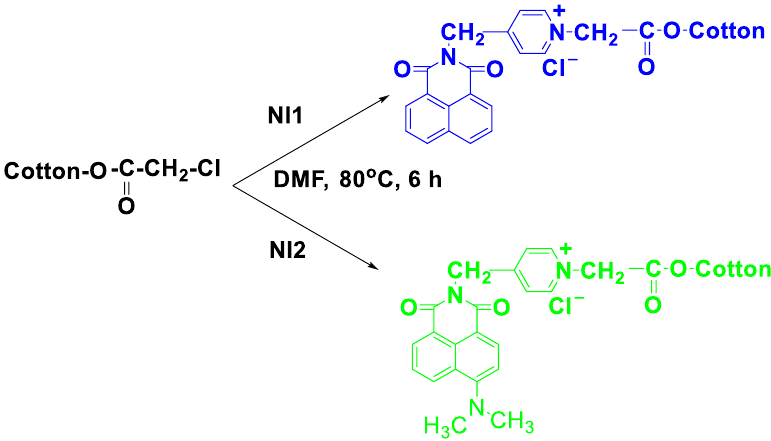
6 of 14 Figure 3. Absorption spectra of KI in the presence of NI2 plotted as a function of irradiation time ( A ); dependence of absorbance at 352 nm, corresponding to I 3- caused by NI1 and NI2 ( B ). 2.4. Dyeing of Modified Cotton Fabric with NI1 and NI2 Cotton fabric is a material that is commonly used to make various antibacterial prod- ucts that are used in clinical practice. In order to prevent the formation of bacterial bio- films, various methods are used for the surface modification of such materials [28]. NI1 and NI2 contain a pyridinium nucleus, which is attached to the imide-nitrogen atom via a methylene (-CH 2 -) spacer, which allows it to be quaternized. For this purpose, cotton fabric was modified with chloroacetyl chloride. Thus, the reactivity of the chlorine atom was enhanced by C=O from the ester group after it was introduced onto the material sur- face [29]. The dyeing of the modified cotton fabric with NI1 or NI2 was carried out at 80